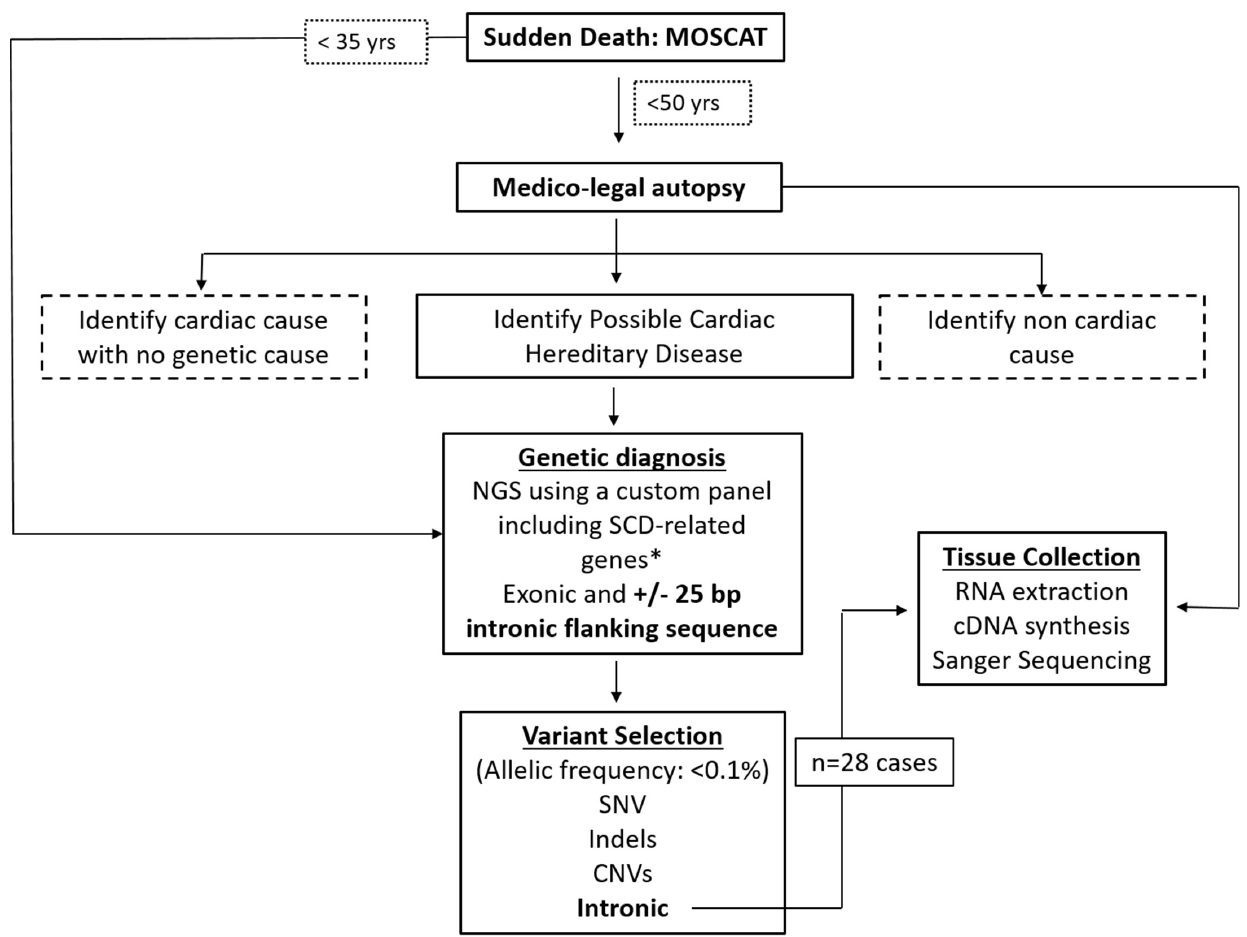
Figure 5. Sudden death: postmortem examination workflow of MOSCAT project. Dotted lines: excluded for the study. In individuals younger than 35 years old, toxicology screening, forensic examination and genetic analysis were performed simultaneously. * SCD-related genes included in panel (Table S3).